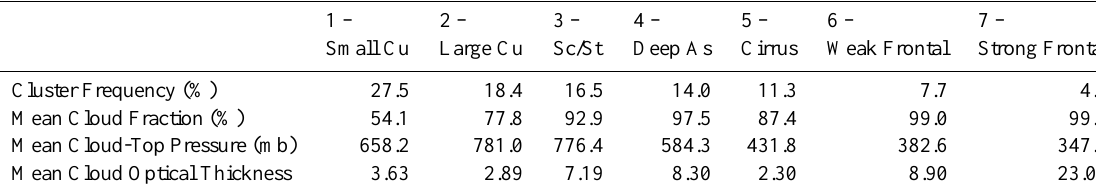
Table 1. Grid box mean ISCCP cloud properties for each